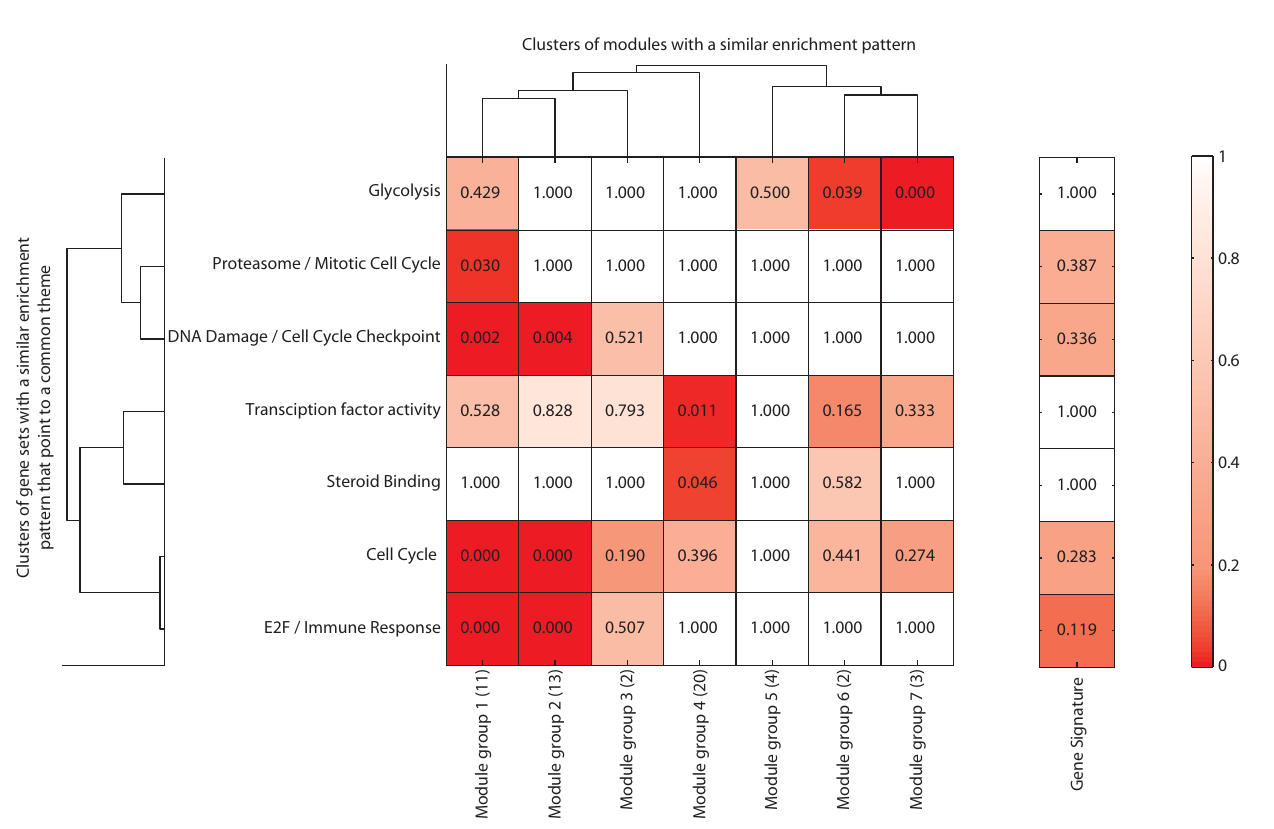
Figure 7. Comparison of a module-based signature (A) and a gene-based signature (B). The module-based signature from the Inter1 experiment contains 55 modules, and the gene-based signature contains 21 genes (Table 1). For both signatures an enrichment score for their overlap with the collection of 2682 gene sets was calculated based on the hypergeometric distribution. This resulted in a total of 319 gene sets that were enriched in at least one module or in the gene-based signature ( p , 0.05 after Bonferroni correction), see supplemental figure S4. Several modules turned out to have a similar pattern of enrichment across the gene sets. Additionally, gene sets that relate to a common theme turned out to have a similar enrichment pattern across the modules. Therefore, we clustered the matrix of p-values in both dimensions (2-dimensional, hierarchical clustering, complete linkage, Euclidean distance). The dendrograms at the top, and to the left indicate the clustering, where we chose to group either dimension into seven distinct groups. The labels on the left indicate the most common biological theme, and the label on the bottom indicates the groups of modules formed along with the number of modules in each group in brackets. The main table shows the median p-value for the enrichment of each of the seven clusters of modules, across these seven groups of gene sets. Similarly, the table on the right shows the median p-values for the gene signature. Shading of the cells reflects the p-values.